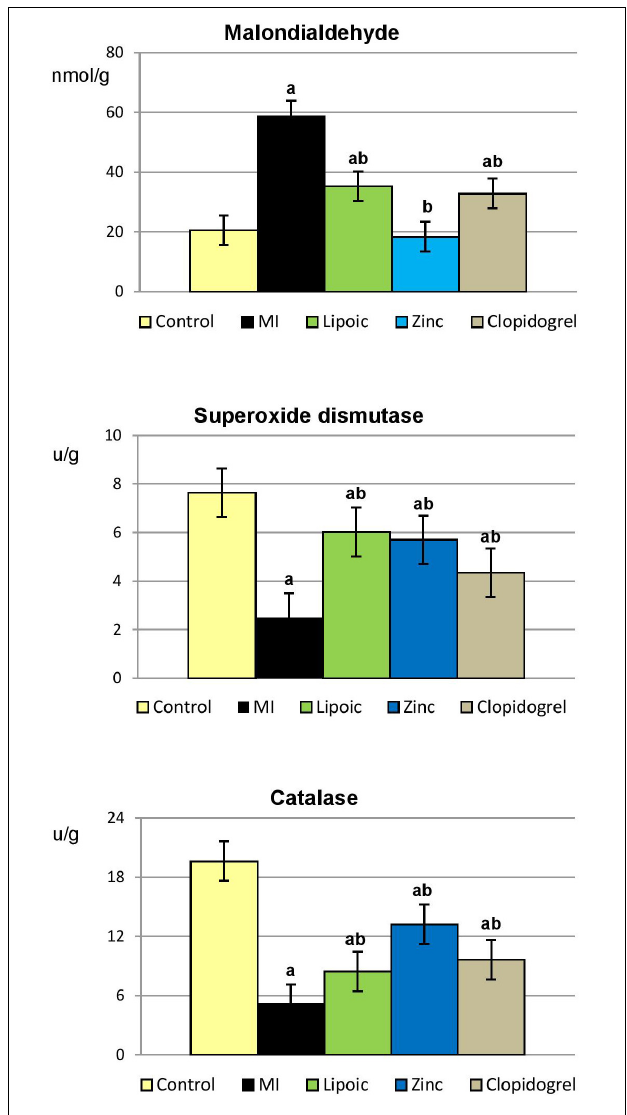
FIGURE 6 | Myocardial tissue oxidative stress parameters in the control, untreated myocardial infarction (MI) and pre-treated (lipoic acid, zinc sulfate, and clopidogrel) groups. Results are represented as mean ± SEM, significance of differences is calculated by Student’s t -test for unpaired data at p < 0.05; a—vs. controls, b—vs. MI